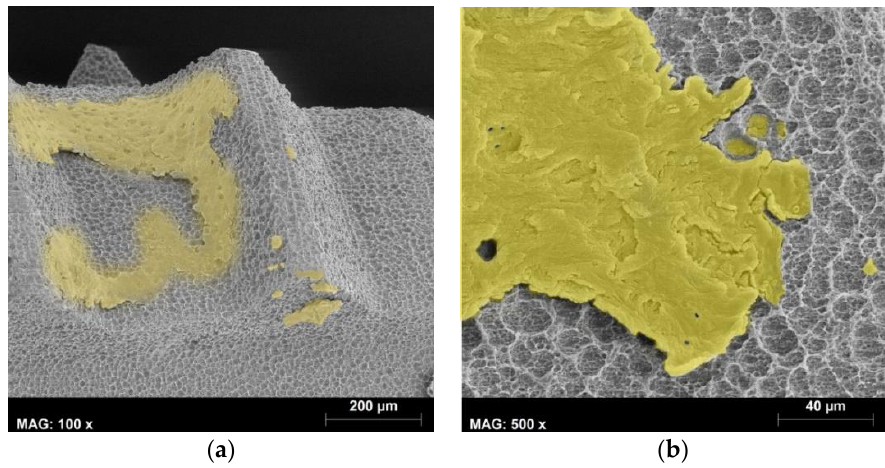
Figure 6. Bone attached to the implant surface after a mistaken reverse-torque applied to an implant after a 2-month healing period in the mandible. ( a ) SEM micrograph taken at 100×. Note the attached bone colored in yellow; ( b ) SEM micrograph taken at 500×. The attached bone is colored in yellow; note the bone remaining in the rounded macro-structure after the fracture of the implant–bone interface.